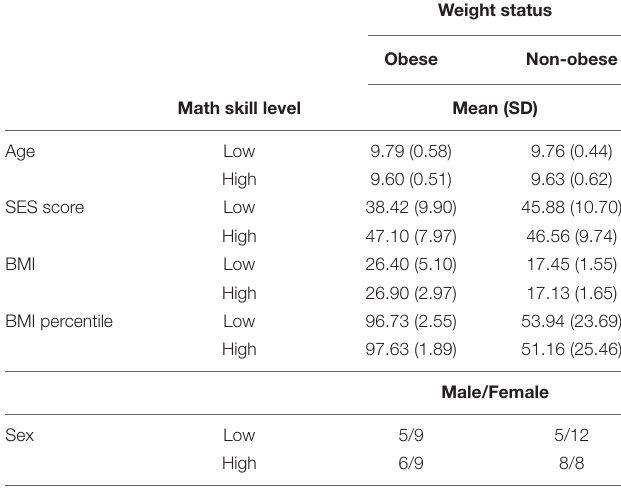
TABLE 2 | Demographic data of preteens.